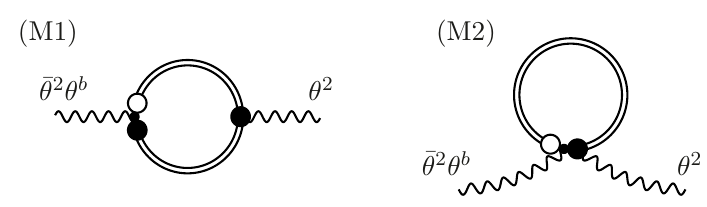
Figure 1 . These two effective diagrams encode contributions to the β -function coming from the chiral matter